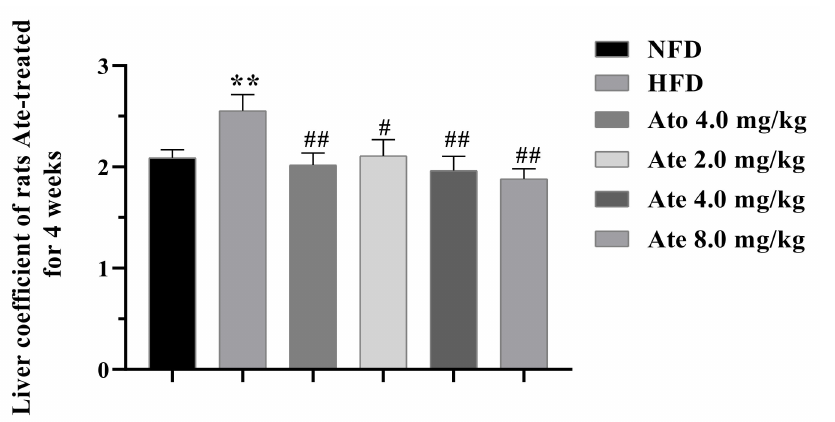
Figure 3. The effect of Ate on the liver coefficient of rats. All data are shown as mean ± SEM, n = 7. ** p < 0.01 compared with the NFD group and both # p < 0.05 and ## p < 0.01 compared with the HFD